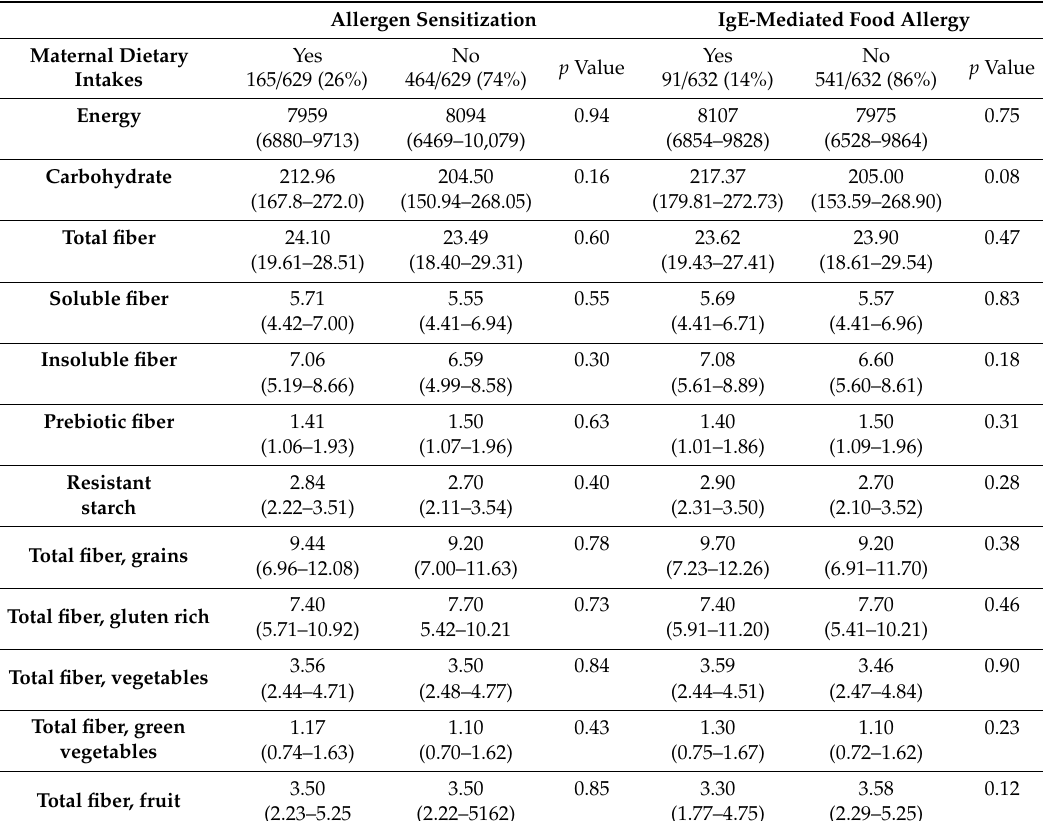
Table 4. Maternal dietary intakes (median and IQR) during late pregnancy and infant allergen sensitization and IgE-mediated food allergy